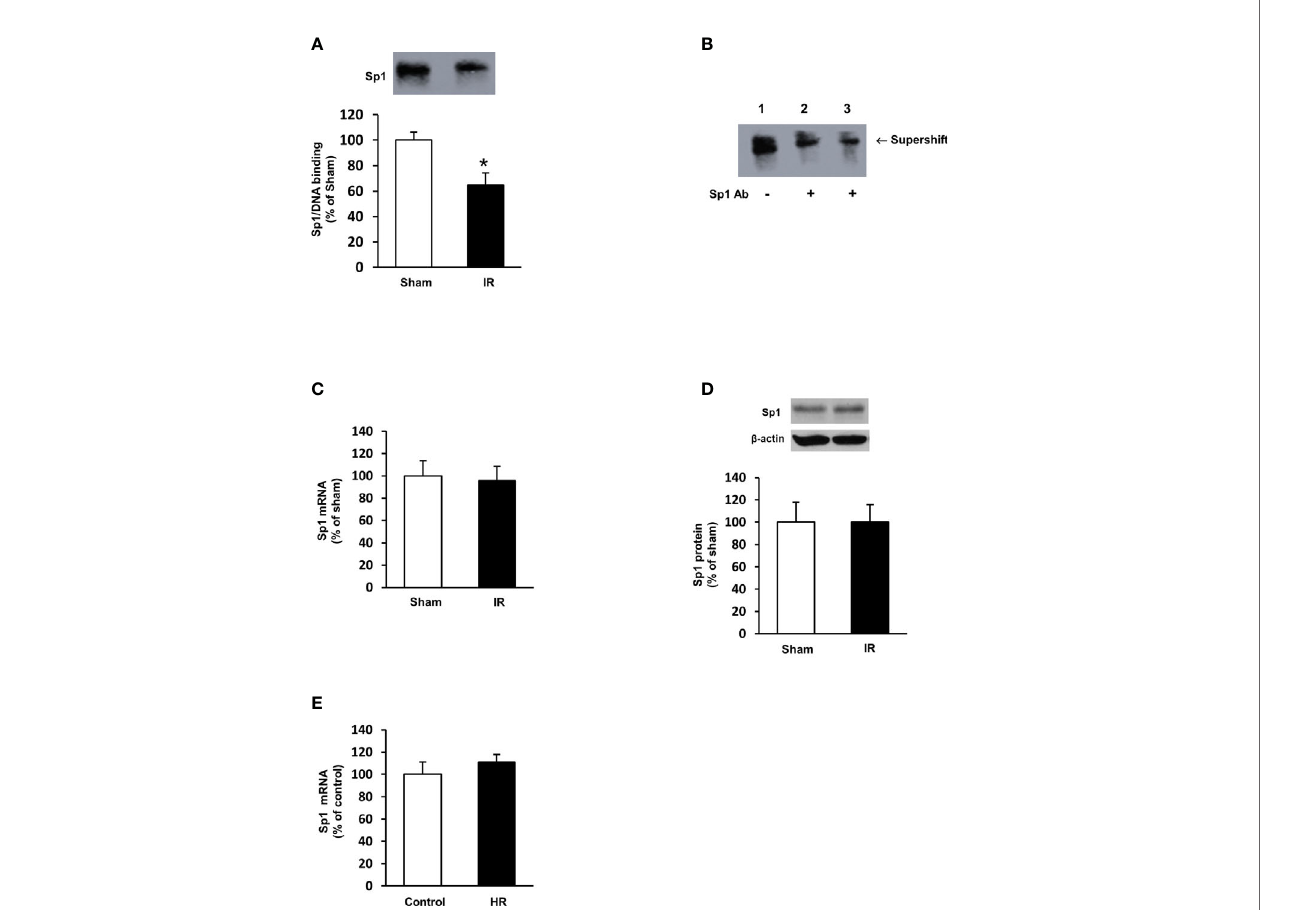
FIGURE 7 | Sp1/DNA binding activity and expression in rat kidneys and proximal tubular cells. Rats were subjected to kidney ischemia-reperfusion (IR) or sham operation (sham). Nuclear proteins were isolated from the kidneys. (A) The DNA binding activity of Sp1 was determined by EMSA. The binding activity in the sham-operated group was expressed at 100%. (B) In the supershift assay, the nuclear protein and DNA oligonucleotides were incubated in the absence (lane 1) or presence of anti-Sp1 antibody (Abcam, 2 m L in lane 2 and 4 m L in lane 3) for supershift assay. The shift of the Sp1/DNA complex is indicated by an arrow. (C) The mRNA of Sp1 in the kidneys was determined by real-time PCR analysis. (D) The Sp1 protein in the kidneys was determined by Western immunoblotting analysis. (E) Proximal tubular cells were subjected to 2 h hypoxia followed by reoxygenation (HR) for 48 h. Cells cultured under normal condition were used as control. The mRNA of Sp1 was measured. Results are expressed as mean ± SE (n = 5-6). * P < 0.05 when compared with the value obtained from the sham-operated group or the control